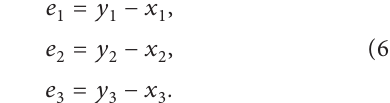
Figure 22: Bifurcation diagram with the variation of the pa- rameter b .